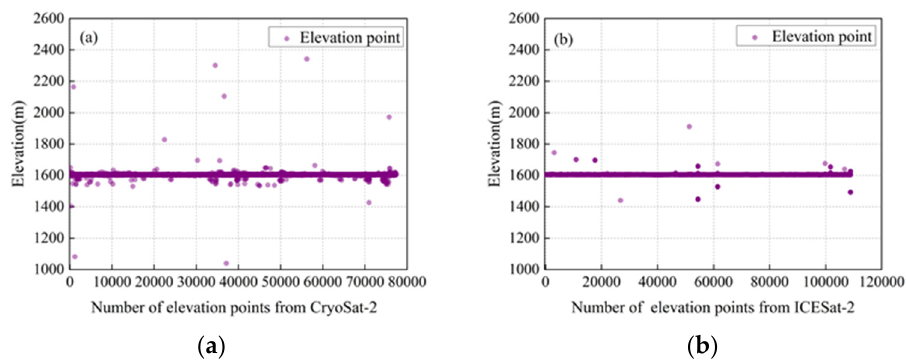
Figure 4. ( a ) All elevation points of Cryosat-2 and ( b ) ICESat-2 passing through Lake Issyk-Kul. Third, the 3 σ criterion was adopted to eliminate the outliers in the data within a day, and then the remaining effective values were averaged as the daily lake level. The results are shown in Figure 5, taking Cysosat-2 data on 13 August 2017 (Figure 5b) and ICESat-2 data on 2 March 2019 (Figure 5c) as examples. The usability of the 3 σ criterion has been proven in the application of large lakes with enough footprints [65].